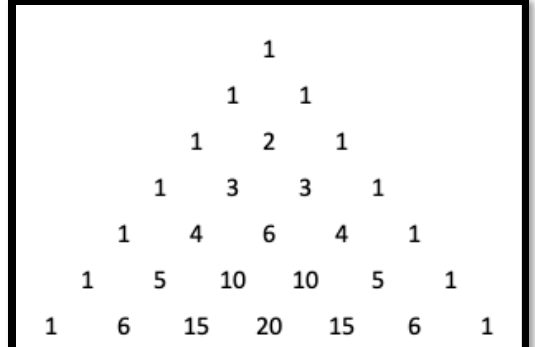
Figure 1. Pascal’s triangle.